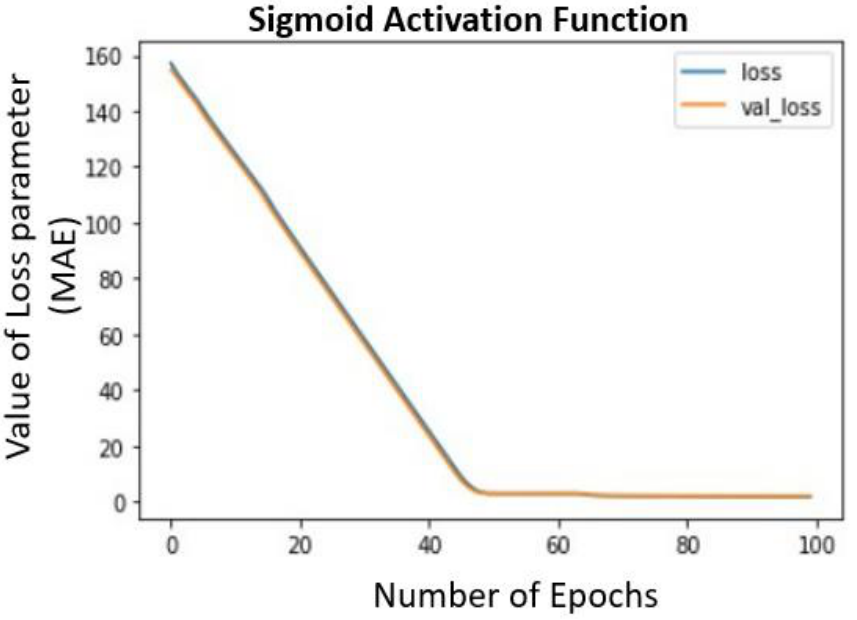
Figure 3. Training and Validation loss curves while training of the model using sigmoid activation function (x-axis represents the number of successive epochs and y-axis holds the value of loss parameter (MAE) for each epoch). Table 2. Value of Loss parameters for different activation functions in several iterations for Ghaziabad and surrounding regions (Plain